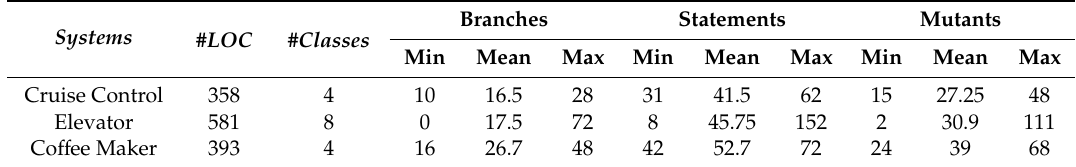
Table 3. Experimental